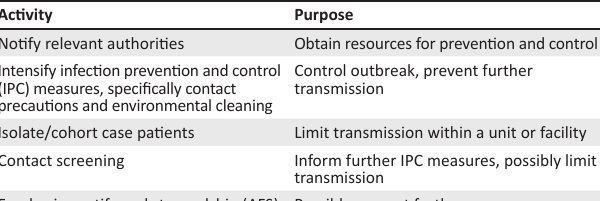
TABLE 3: Suggested activities following detection of an outbreak of Candida auris in a healthcare